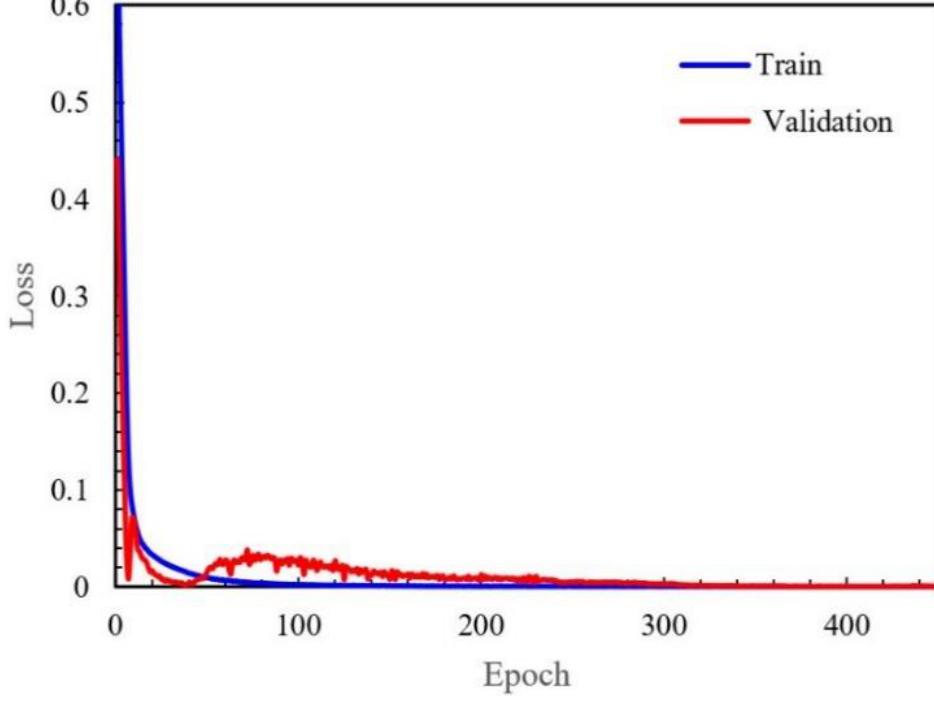
Figure 8. Plot of training model